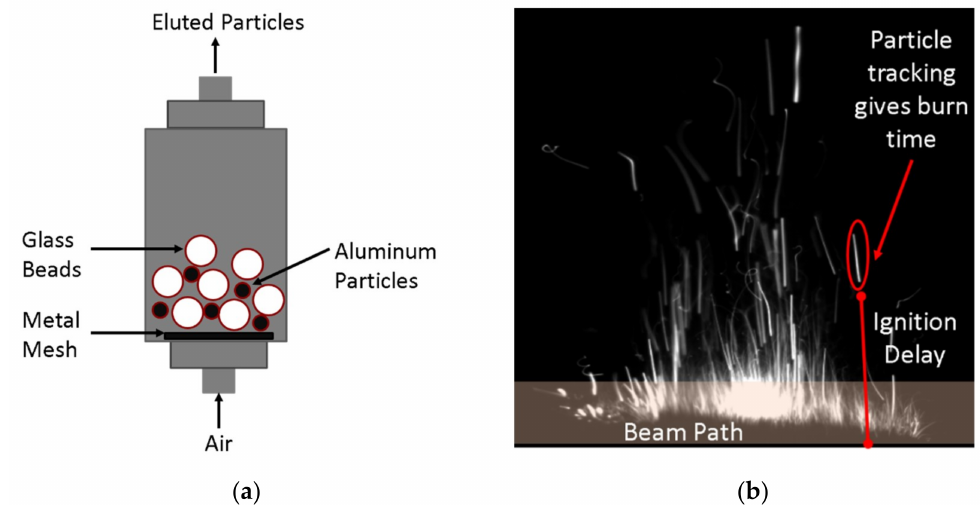
Figure 1. ( a ) Schematic of particle injection system showing Al particles and glass beads used to elute Al particles into the laser beam path. ( b ) Photograph of untreated aluminum powder (UN Al) particle burning upon exposure to laser beam representing burn time and ignition delay measurements.